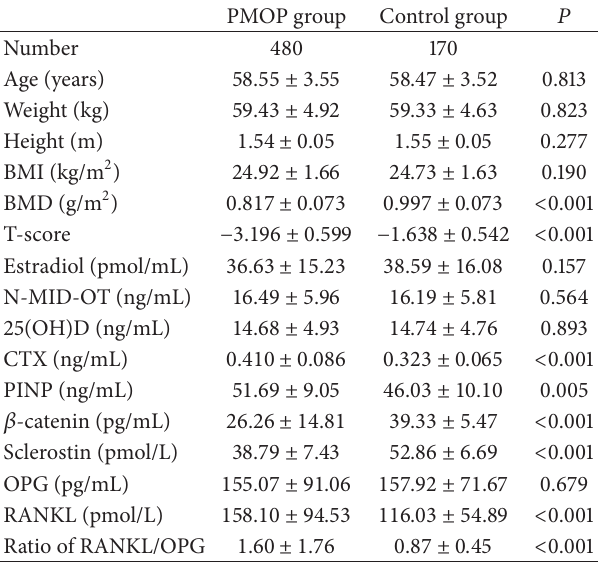
Table 1: The characteristics and laboratory data of patients and controls.